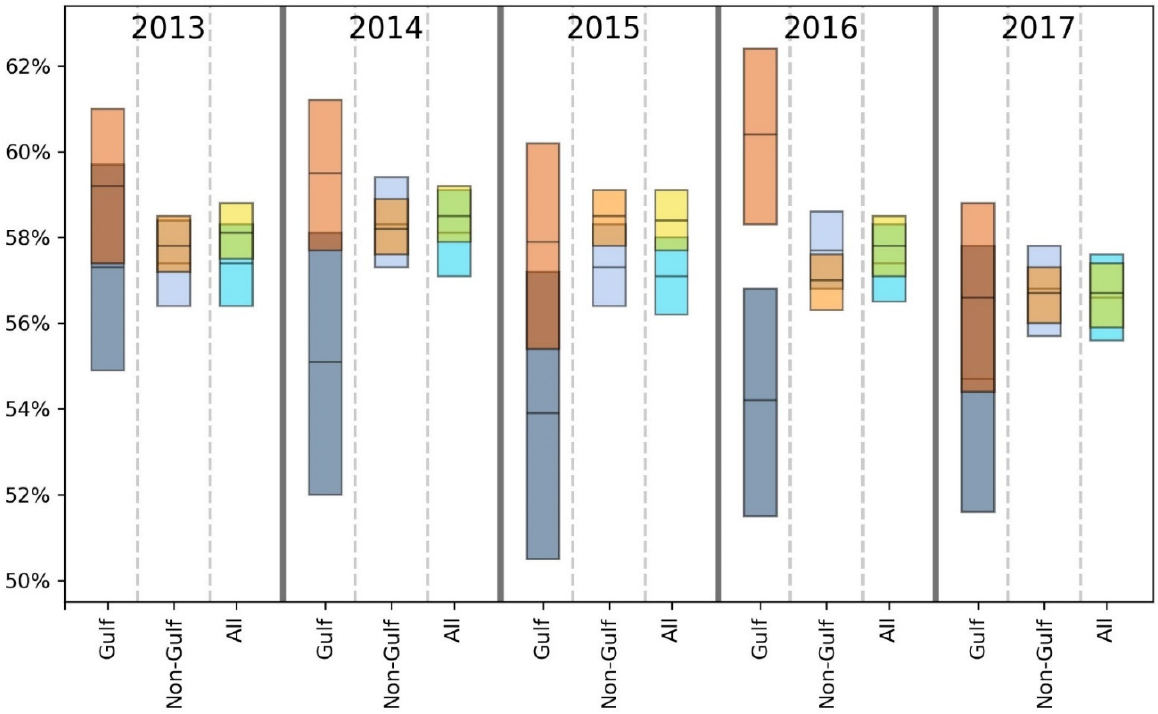
Figure 6. Comparison of mean (black line across bar) and 95% confidence intervals for percentages of Gulf and non-Gulf MMSA respondents reporting zero physically or mentally unhealthy days out of the last 30. Colors denote the following: dark blue = coastal Gulf, light blue = coastal non-Gulf, dark orange = non-coastal Gulf, light orange = non-coastal non-Gulf, bright blue = all coastal, yellow = all non-coastal.